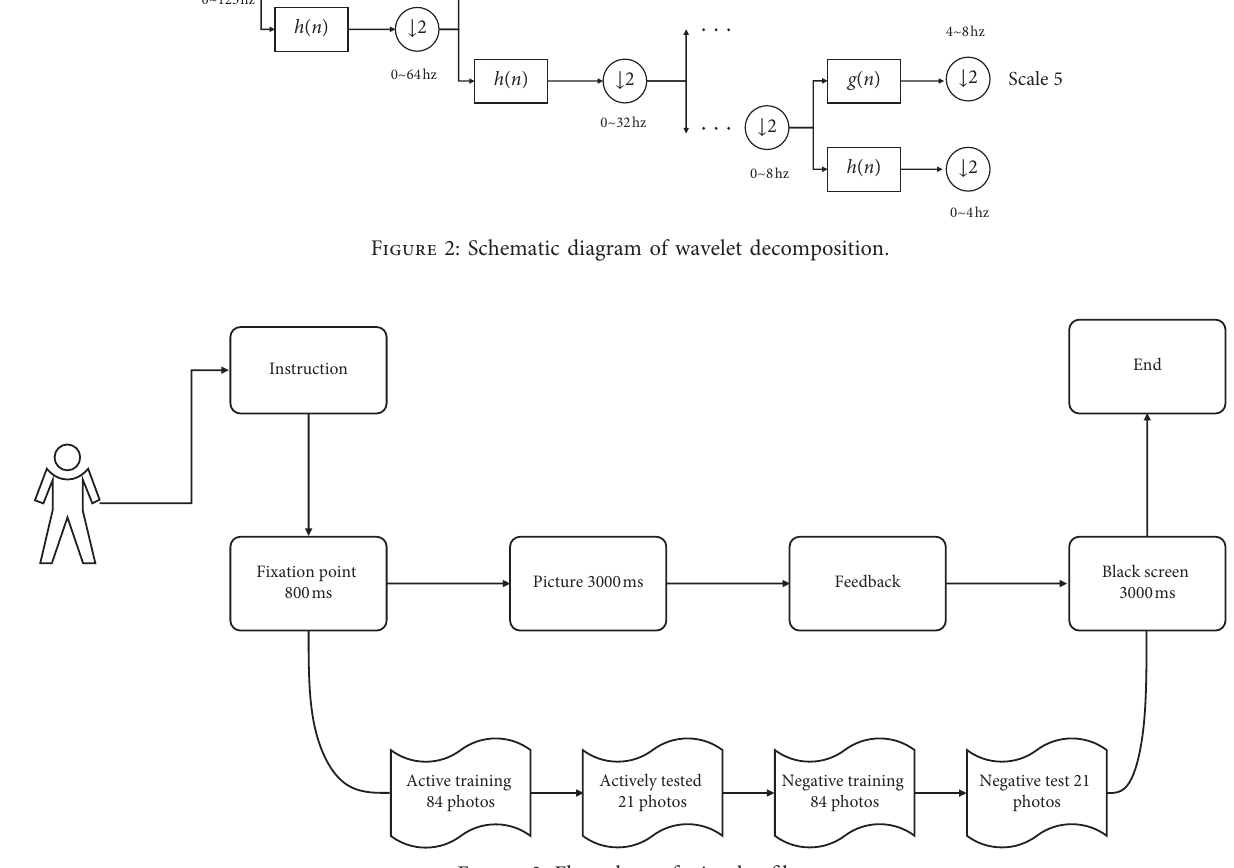
Figure 3: Flow chart of stimulus file.